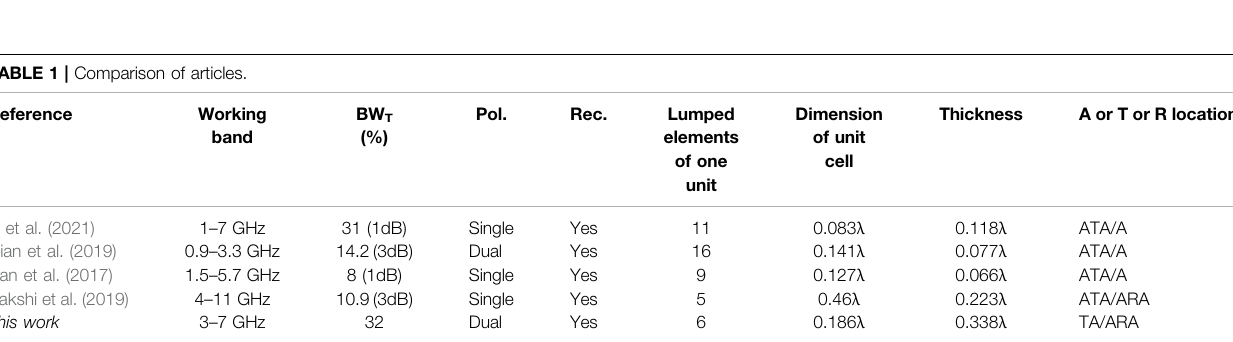
TABLE 1 | Comparison of articles.